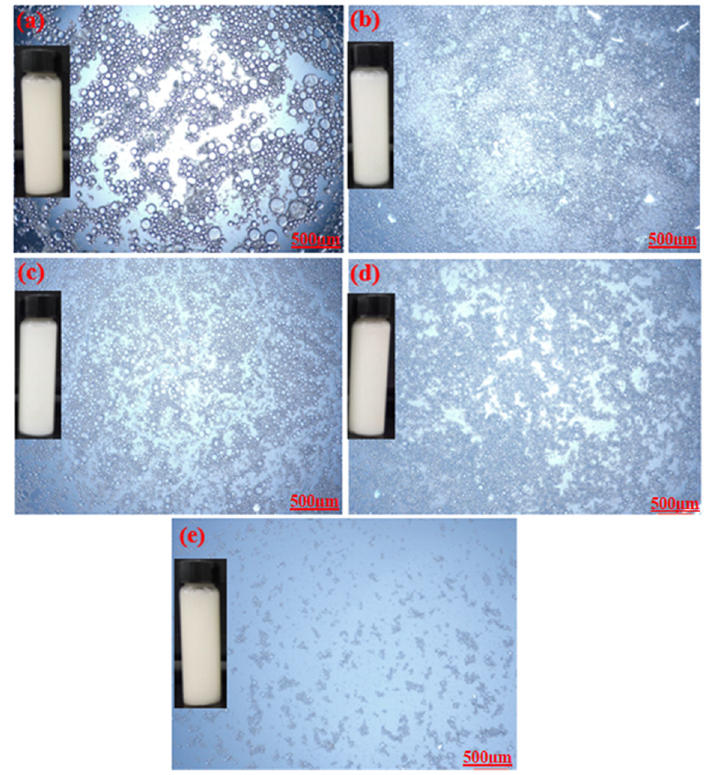
Figure 4. Optical microscopy images of emulsions stabilized by: ( a ) 1%-CT/1%-AG, ( b ) 1%-CT/2%- AG, ( c ) 1%-CT/3%-AG, ( d ) 1%-CT/4%-AG, and ( e ) 1%-CT/5%-AG.